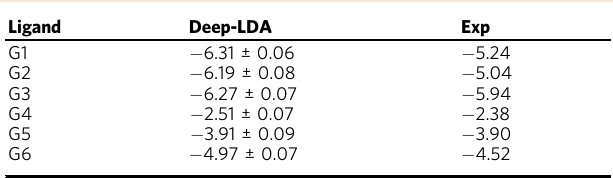
We show the mean binding free energy Δ G (kcal mol − 1 ) for every ligand and the corresponding experimental value. We calculate Δ G as a weighted block average over the simulations with all Deep-LDA CVs (see the Supplementary Methods for further details).